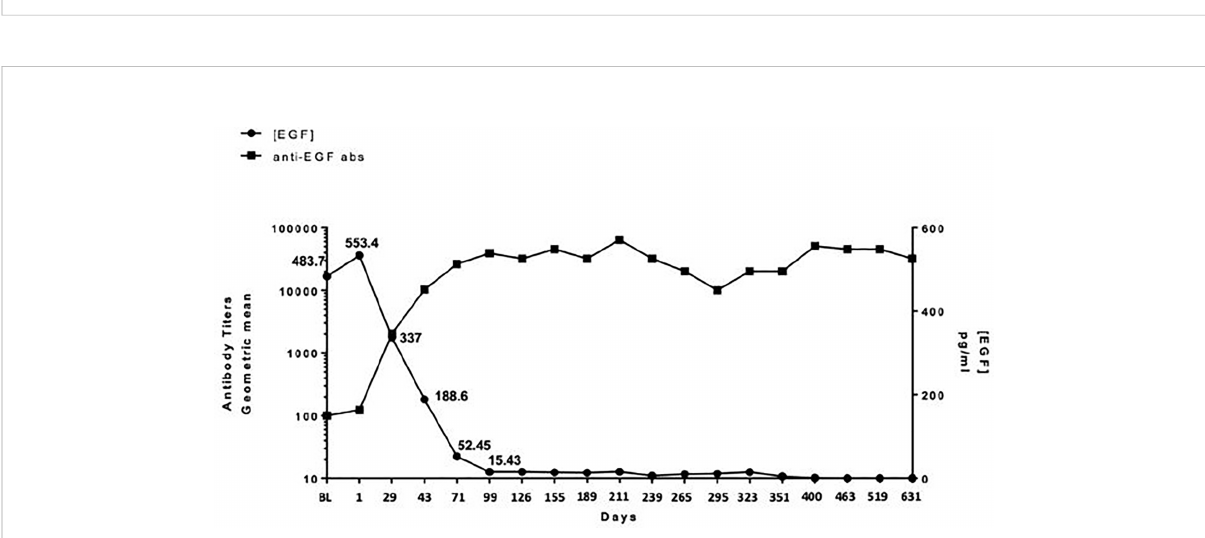
FIGURE 2 Relationship between anti-EGF antibody titers and serum EGF. There is a signi fi cant inverse correlation between circulating serum EGF and antibody titers in patients receiving CIMAvax-EGF in combination with nivolumab.